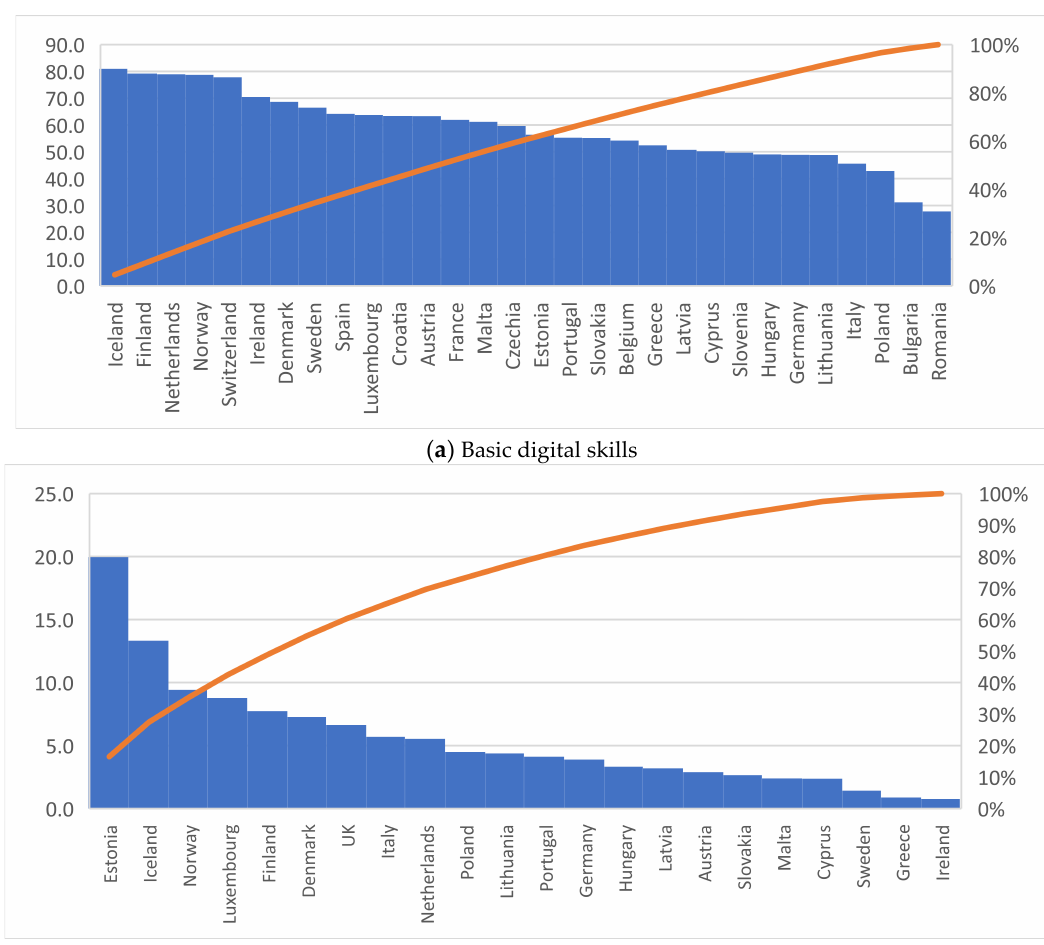
Figure 3. Basic skills and internet-related activities (source: Eurostat). Figure 4 reveals the differences between the EU countries regarding the DESI composite index. The highest level of the index is recorded by the Scandinavian countries while Romania is last. Nevertheless, all countries have improved their digital stance between 2017 and 2021.